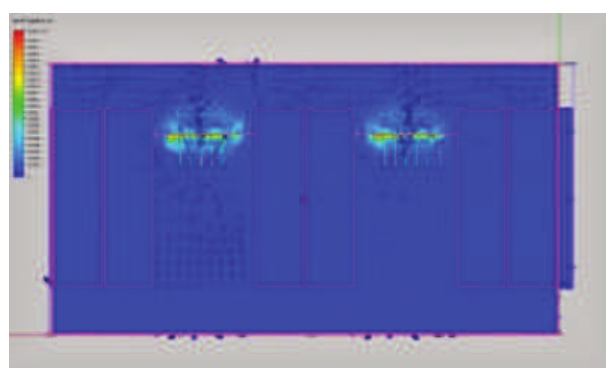
Fig. 6. Visualization of airflow near the